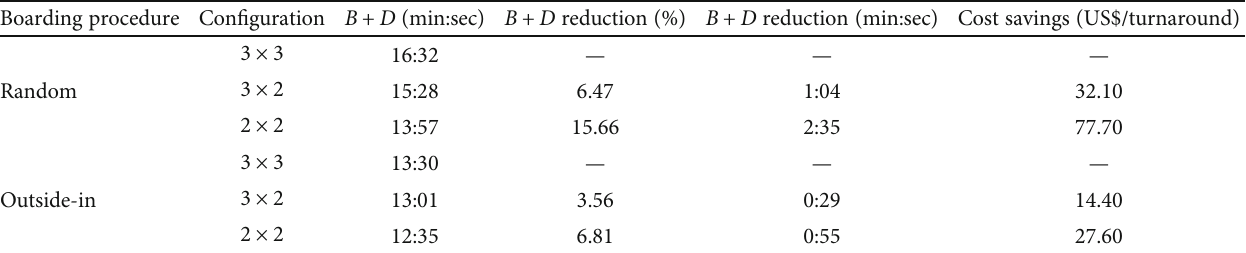
Table 5: Comparison of boarding and deboarding times for the three aircraft con fi gurations.